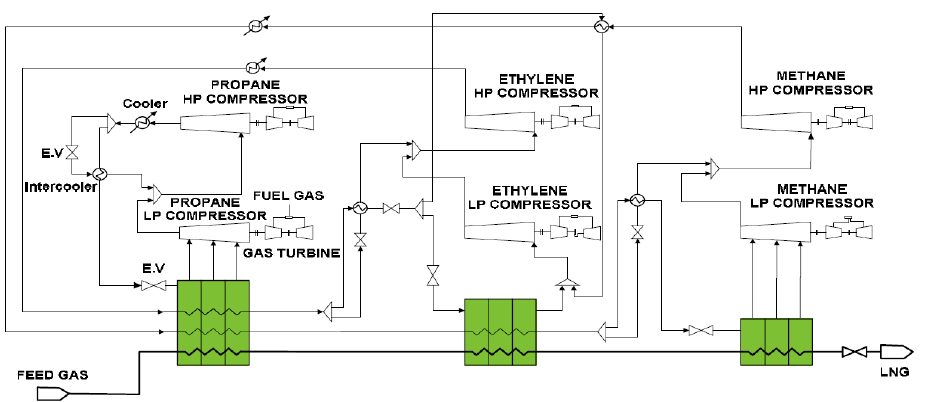
Figure 5. Schematic diagram of cascade process using liquid-gas heat exchanger [29,30]. Reproduced with permission from The World Academy of Science, Engineering and Technology.